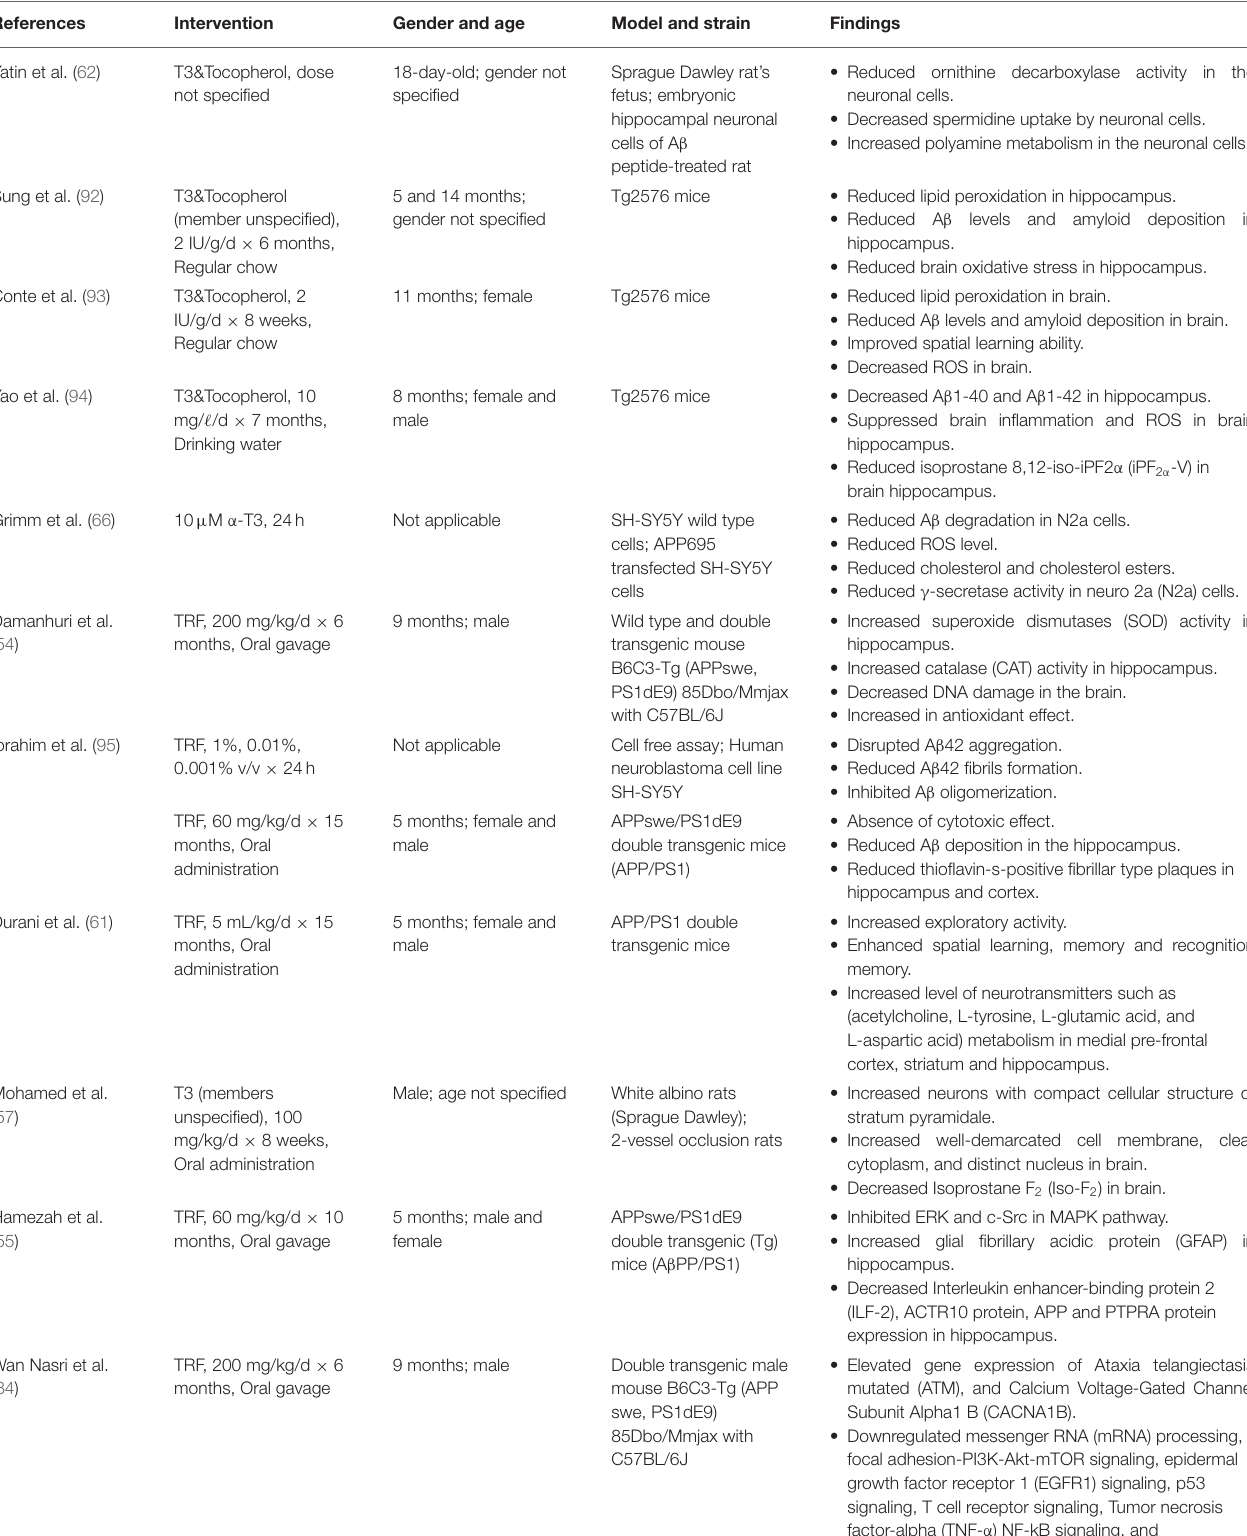
TABLE 1 | Effects of T3s on AD in in vitro and in vivo